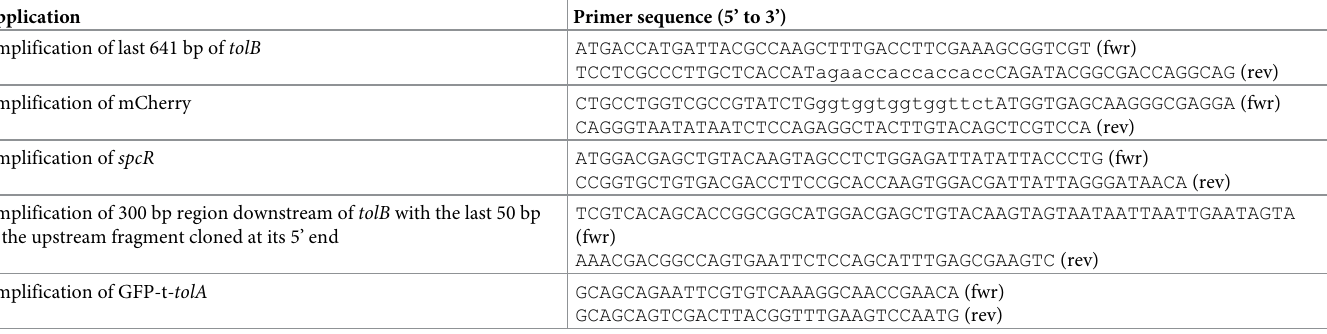
Table 3. Primers used in this study.